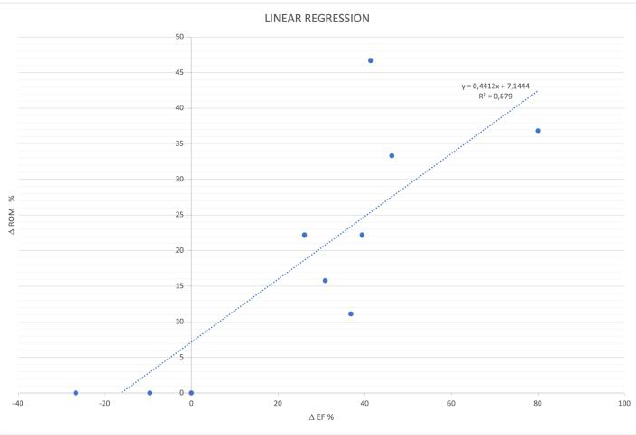
Figure 4. Correlation between ankle ROM and EF% variations in the AS exercise group.